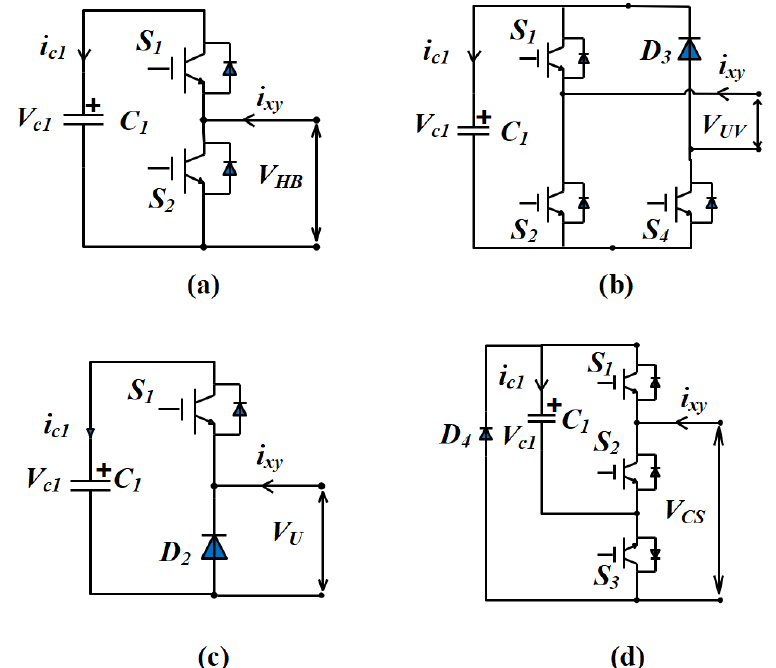
Figure 2. Two-level submodule variants ( a ) Half-bridge ( b ) Unipolar voltage full-bridge ( c ) Unidirectional SM ( d ) Clamp single SM.